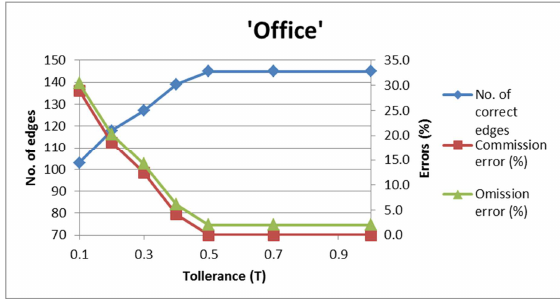
Figure 12. Accuracy evaluation of edge segmentation results for the ‘Office’ data